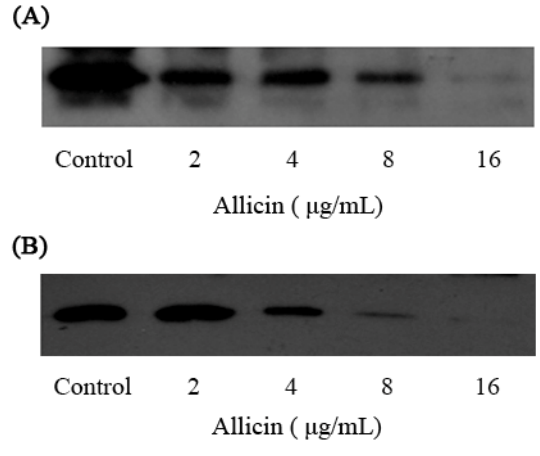
Figure 2. Western blot analysis of α -toxin production by strain ATCC 29213 ( A ) and BAA-1717 ( B ) after treatment with different concentrations of